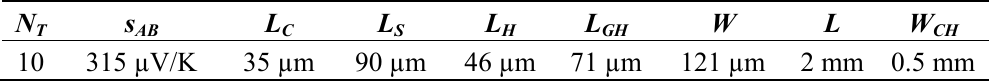
Table 1. Parameter values common to all sensing structures. The Seebeck coefficient was measured with a test structure on the